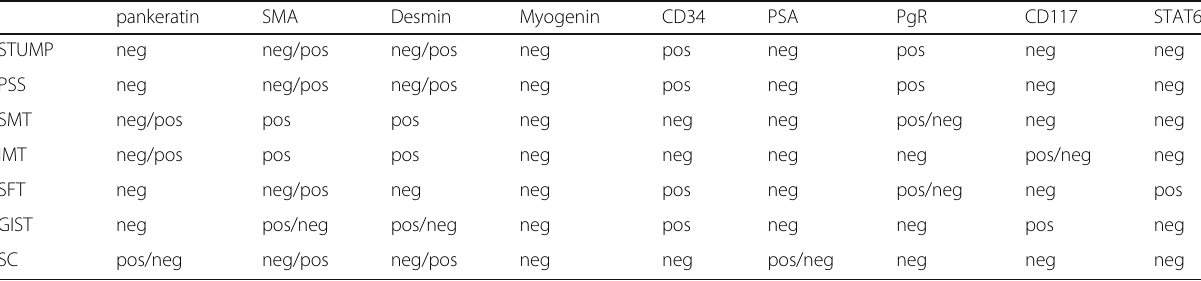
Table 1 Immunohistochemical features of spindle cell lesions of the prostate pankeratin SMA Desmin Myogenin CD34